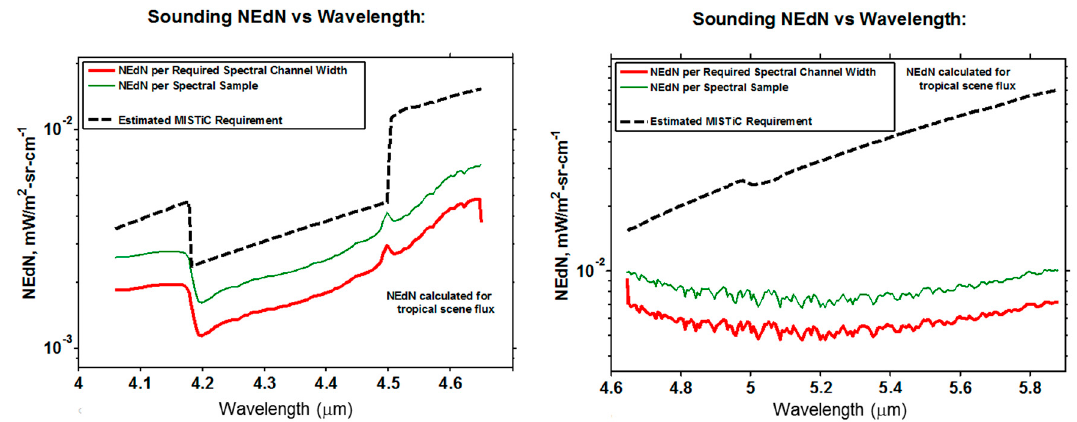
Figure 8. MISTiC Winds instrument radiometric sensitivity performance estimates show solid margin against the adopted requirements in Table 1. MISTiC radiometric sensitivity requirements are comparable to those of AIRS, which required NE ∆ T < 200 mK, referenced to 250 K scene temperature.